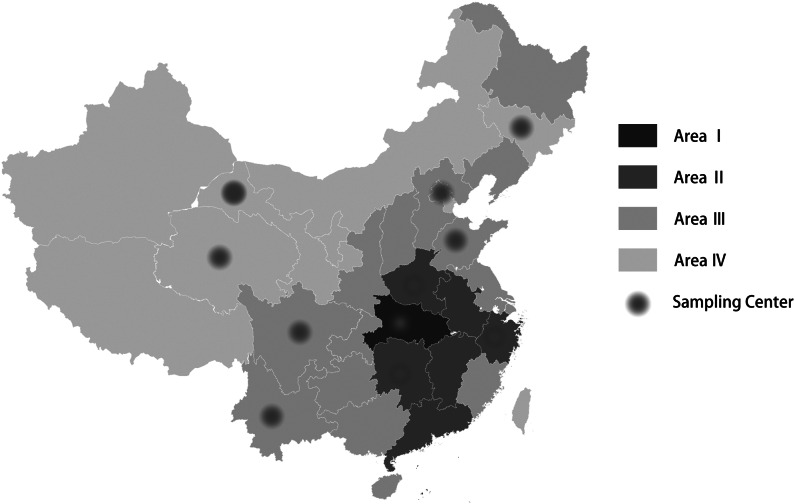
Map of the area division and sampling centers.